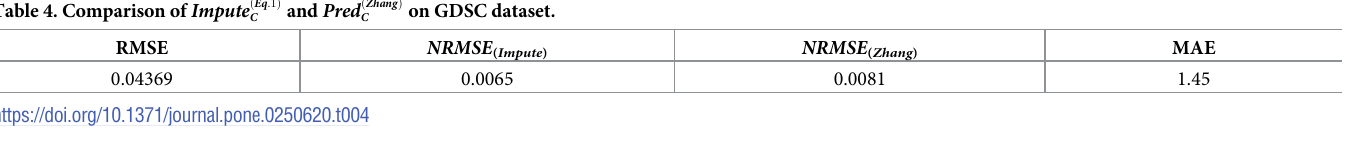
Table 4. Comparison of Impute ð Eq : 1 Þ